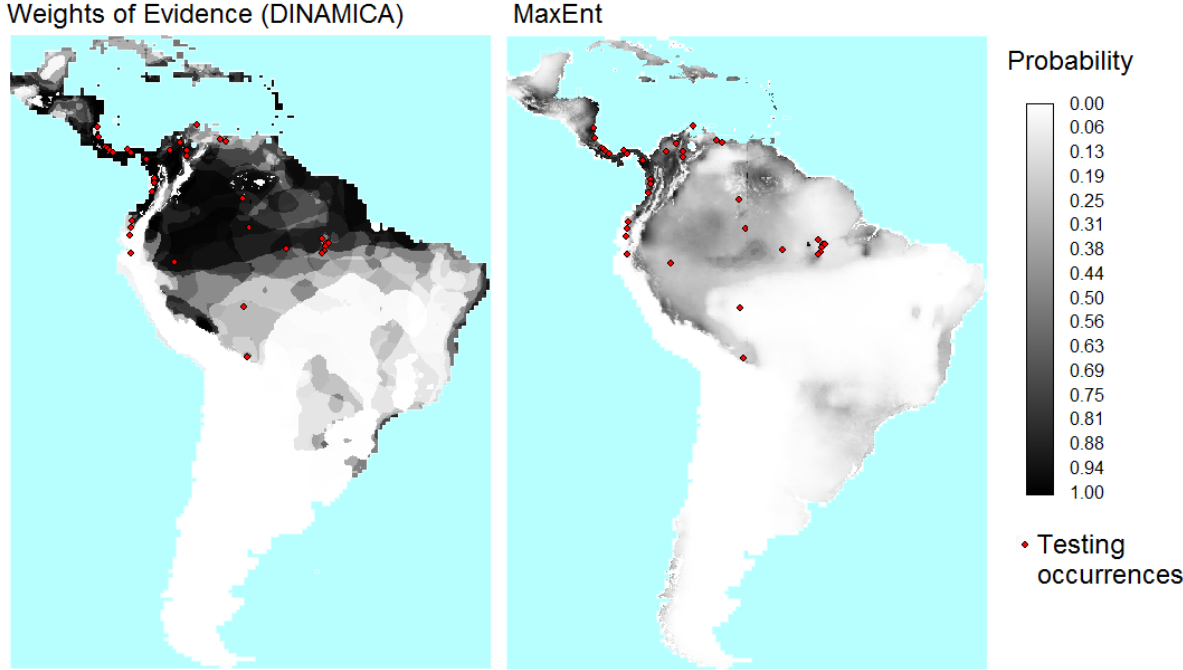
Figure 7. Maps of probability of presence of B. variegatus obtained by Weights of Evidence (WofE) and MaxEnt methods.